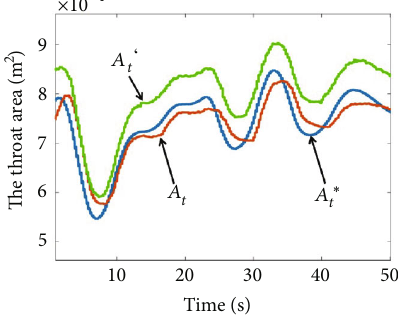
Figure 18: Estimation of throat area based on the load